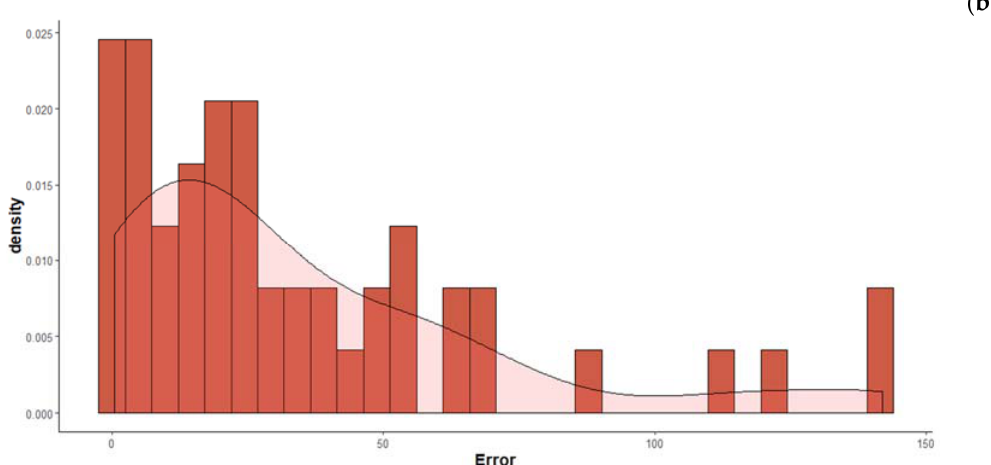
Figure 2. ( a ) Distributions of the observed self ‐ turn error. Children ( n participants = 2; n observations = 24). ( b ) Distributions of the observed self ‐ turn error. Adults ( n participants = 5; n observations = 50). Exploring the main e ff ect of experimental conditions, it is informative to look at individual observations, where we can appreciate that there is heterogeneity of performance (Figure 3).